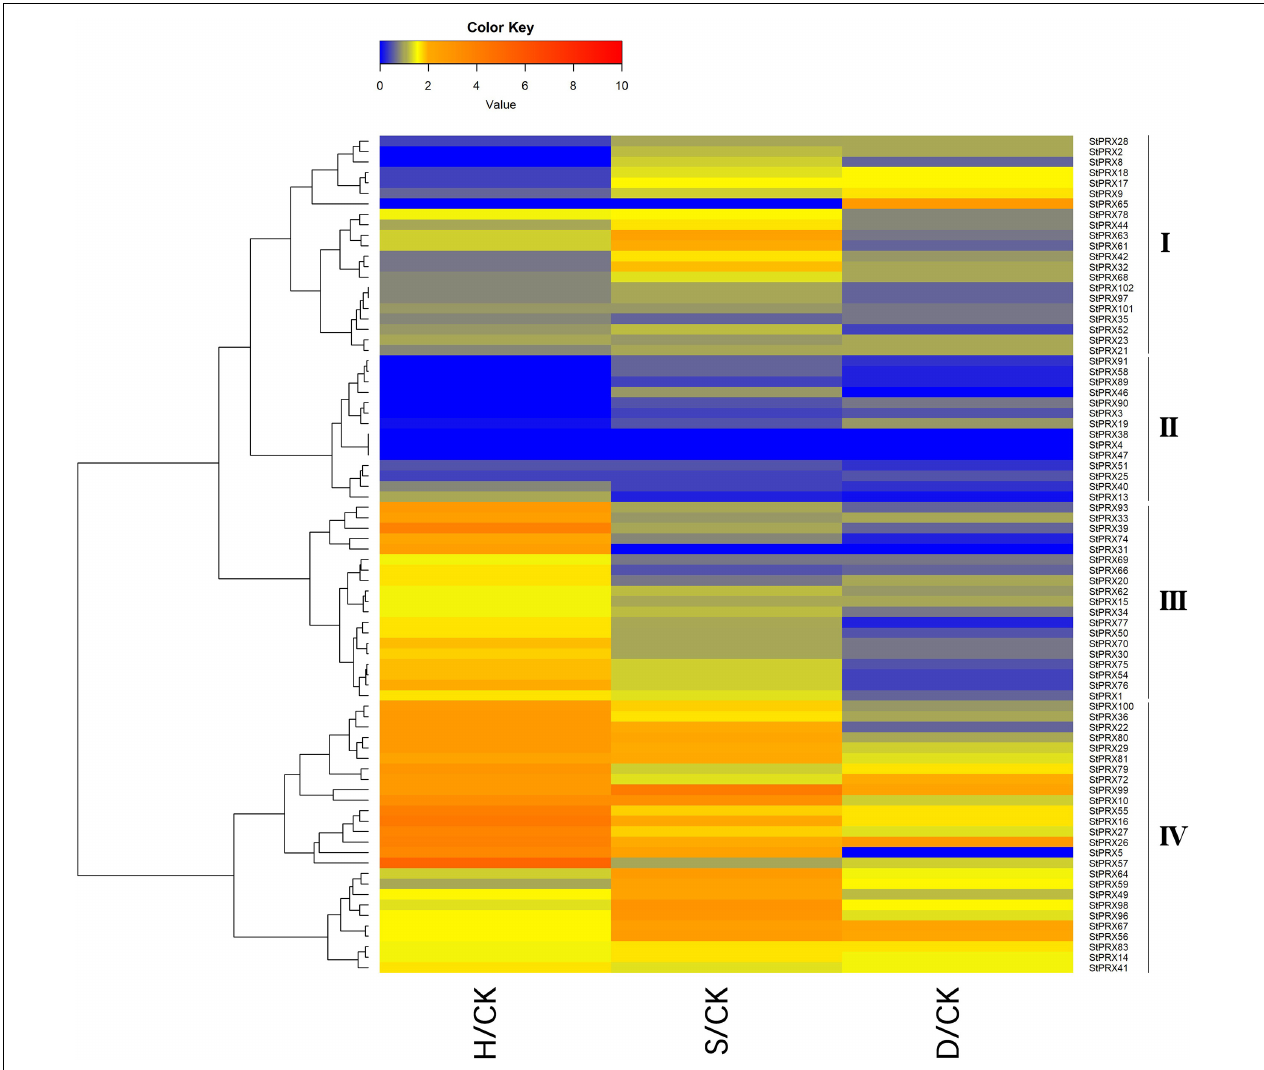
FIGURE 6 | Expression changes of StPRX genes under heat (H), salt (S) and drought (D) stresses. The expression change is indicated by the ratio of FPKM value of the treatment to that of the control (CK). The heatmap was generated using the R package of the heatmap